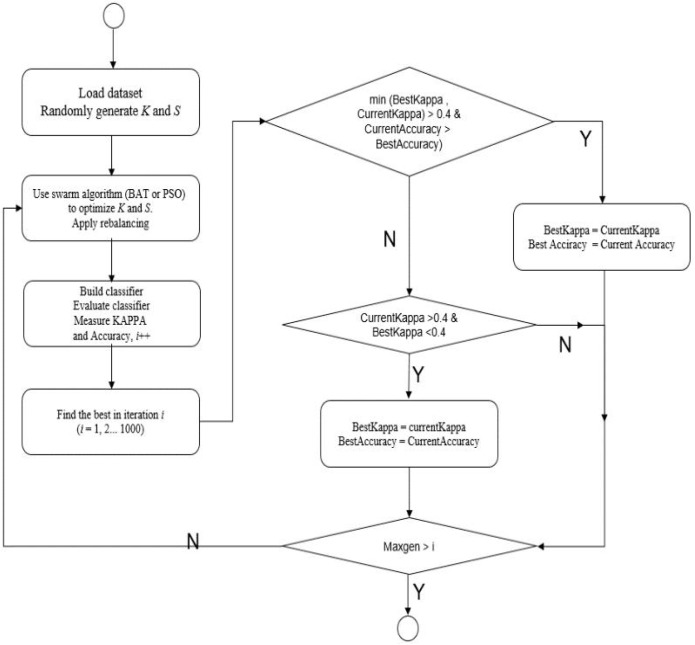
Flow chart of the Swarm Balancing Algorithms.